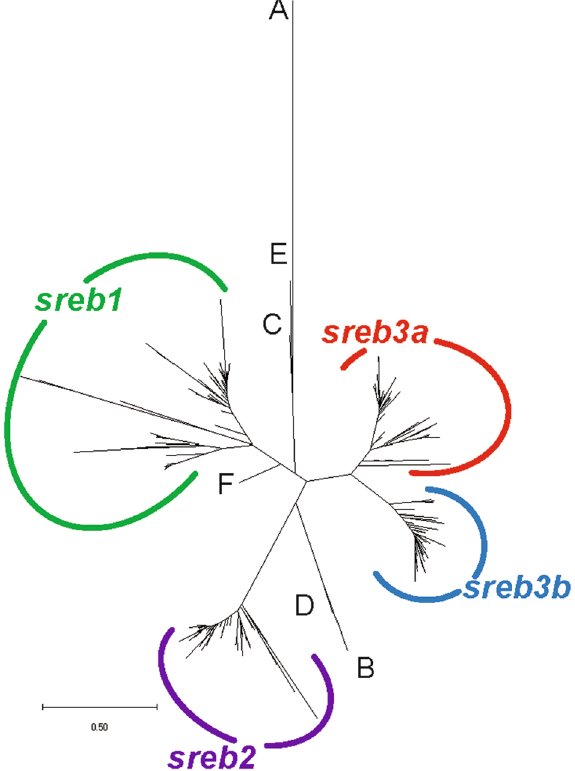
Figure 1. Phylogenetic analysis of all verified fish sreb gene sequences available in Ensembl genome browser 99. The tree was generated using a maximum likelihood approach with 1000 bootstraps and rooted to the hagfish sreb -like1 gene. See Supplementary Fig. S3 for bootstrap values and species names. Sequences for hagfish ( sreb - like1 and 2), lamprey ( sreb -like1, 2, 3) and shark ( sreb -like1) did not group in four major clusters (labeled A – F , respectively), while all other genes were identified as sreb1 (green), sreb2 (purple), sreb3a (red), and a novel sreb3b